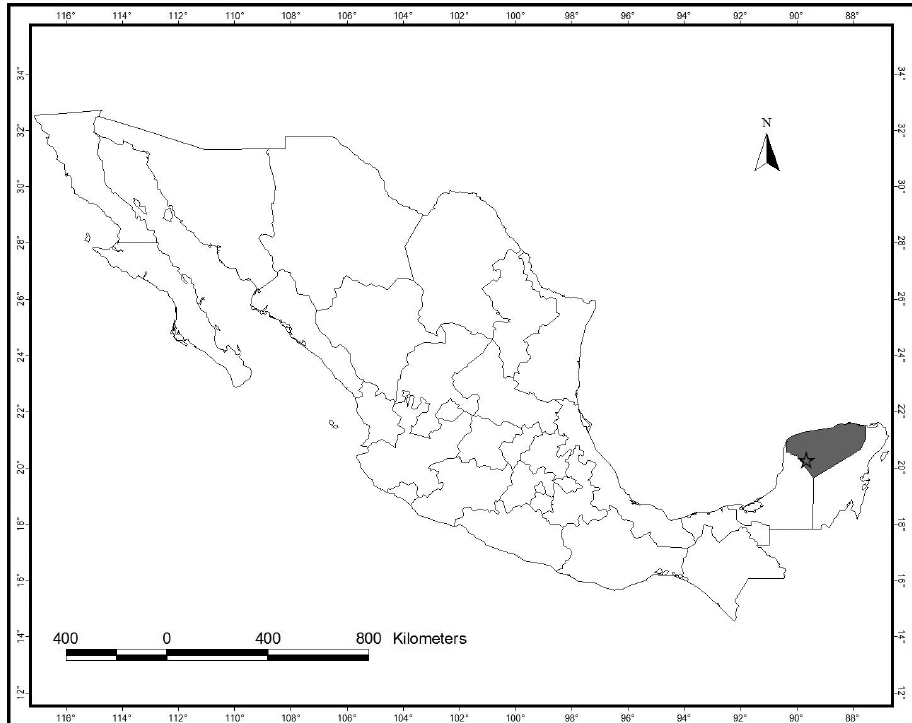
Figure 1. Map showing sampling site, carretera Santa Elena-Loltún, Km. 56, Yucatán,